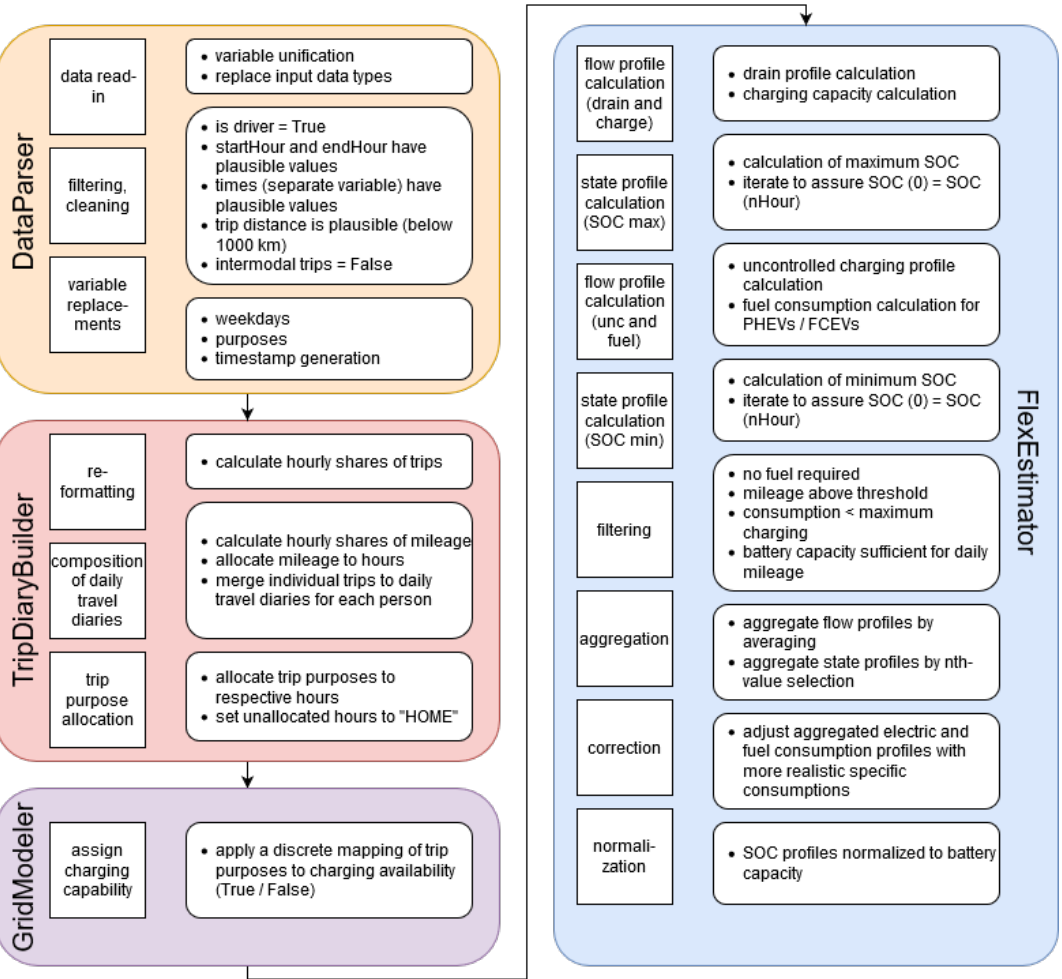
Figure 1. Schematic overview of VencoPy workflow